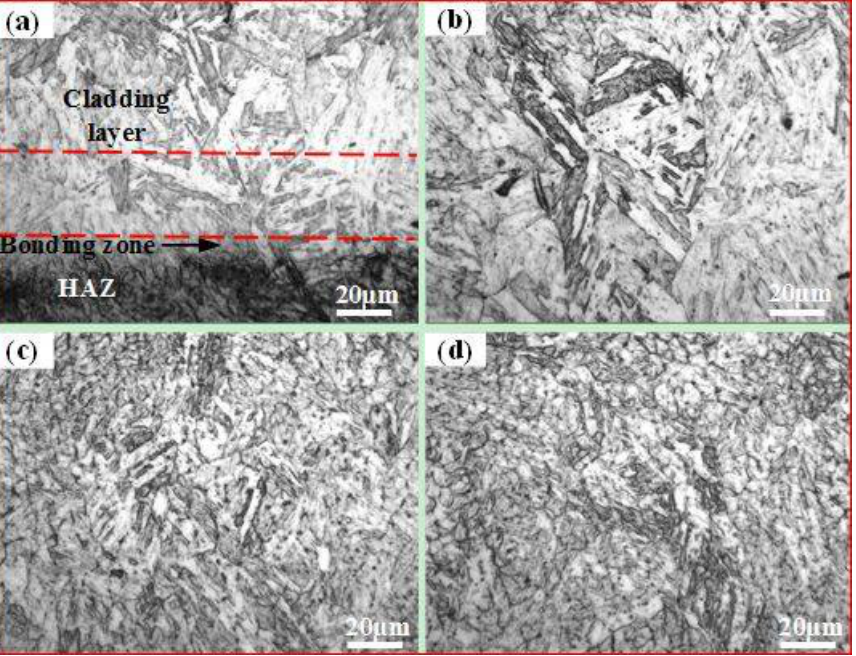
Figure 4. Microstructure of FeCrNiMoRE cladding layer: ( a ) interface; ( b ) the bottom region; ( c ) the middle region; ( d ) the top region.